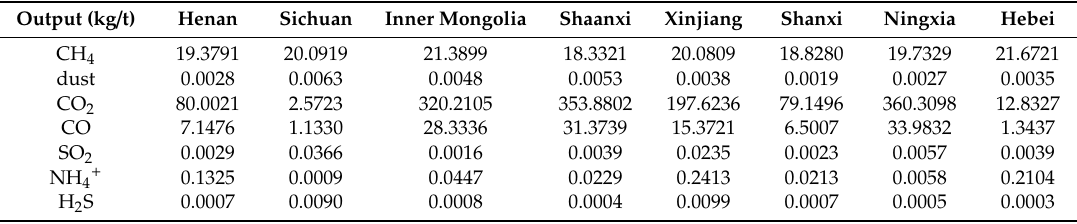
Table 3. Emission inventory of the liquefied natural gas production in eight provinces of China (per